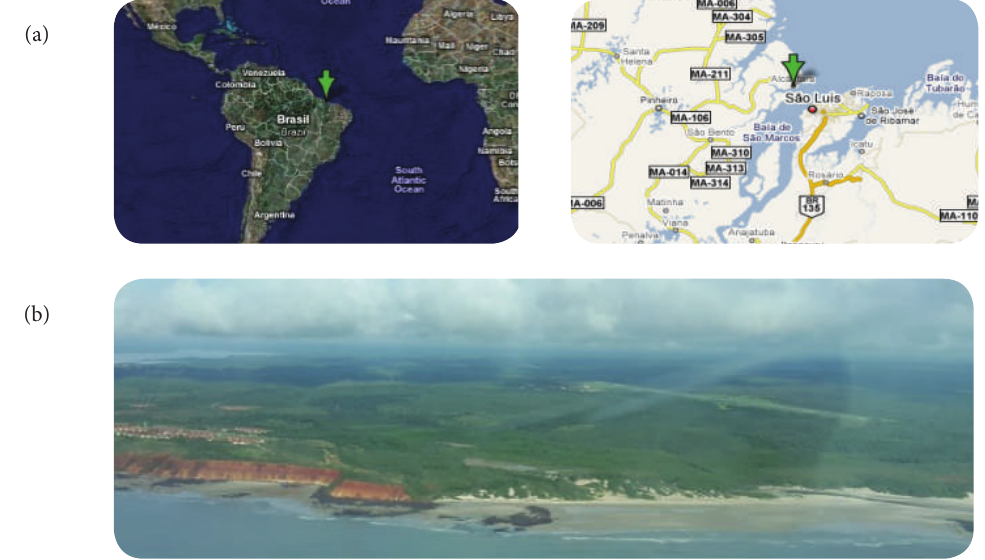
Figure 1. (a) ALC localization; (b) Coastal Cliff at ACL – aerial